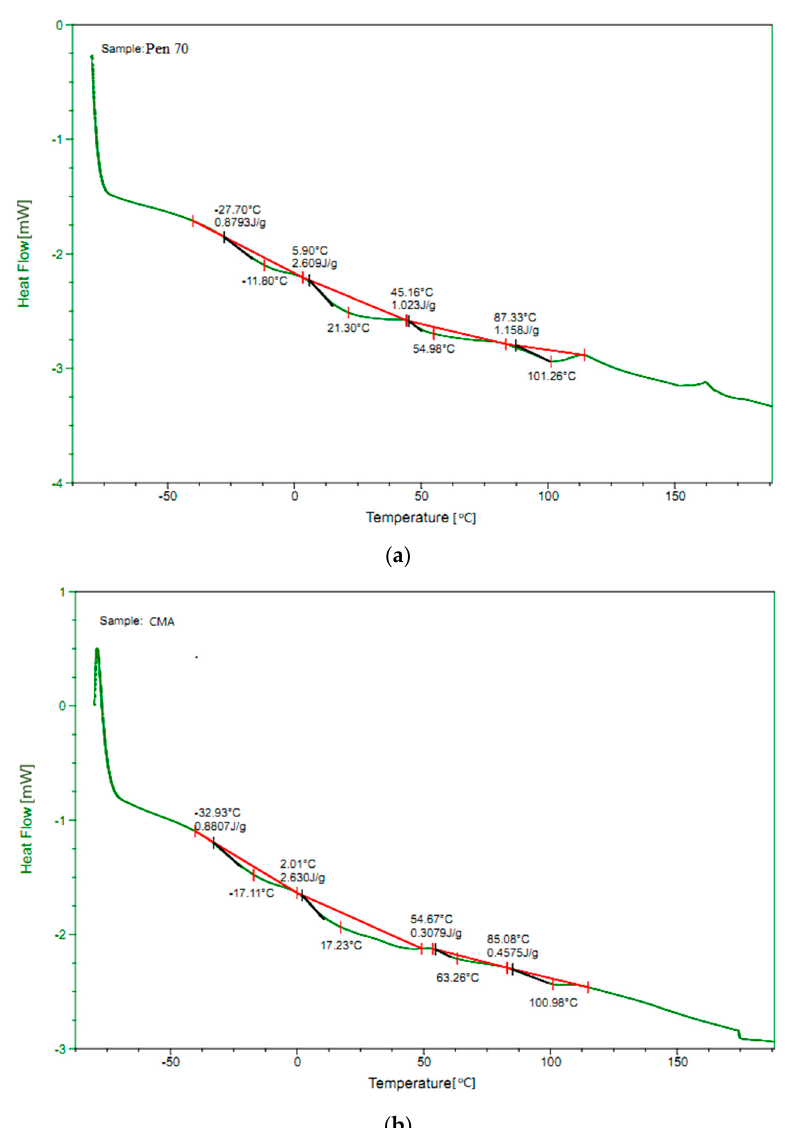
Figure 11. Result of DSC tests: ( a ) Pen 70 and ( b ) CMA.